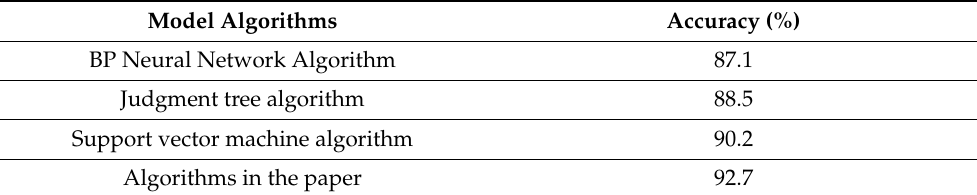
Table 3. Comparison of algorithm detection